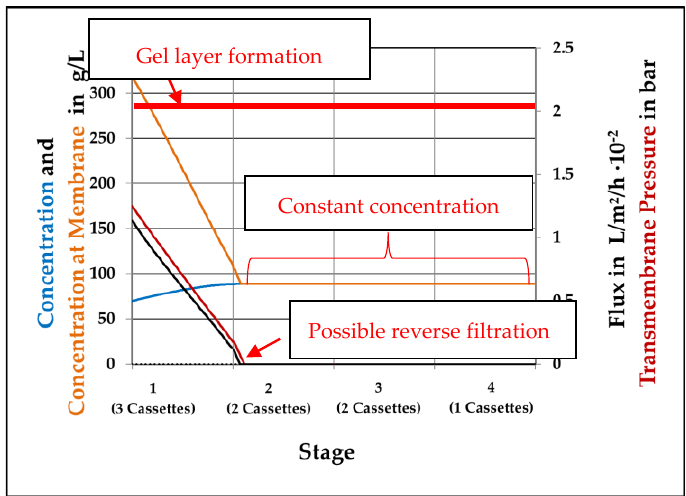
Figure 14. Critical process variables.